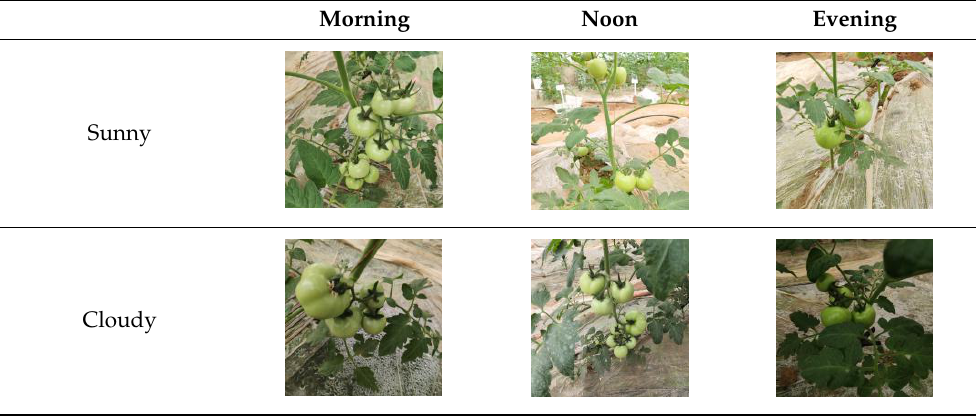
Table 1. Example images acquired under different conditions.